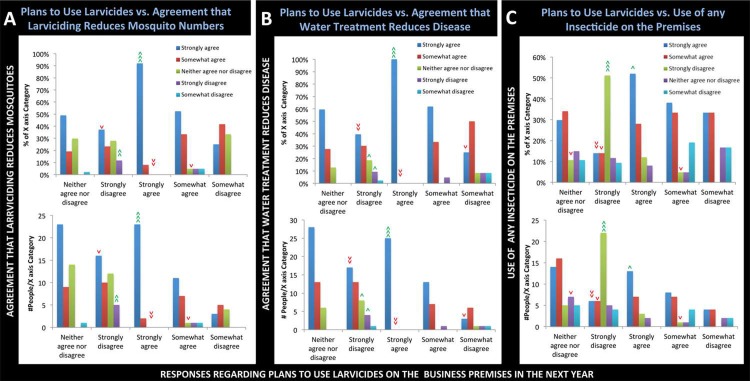
Assessment of respondents’ willingness to use larvicides on the premises.Likert-scale responses to the question of whether the business plans to use larvicides on the premises in the next year (X-axes) vs. A) Agreement that larvicide use will reduce the number of mosquitoes, B) Agreement that treatment of water where mosquitoes breed will reduce disease, and C) Respondents’ willingness to use any insecticide on the premises (Y-axes). The percentages (upper graph in each panel) and numbers (lower graphs) of the X-axis category respondents providing the answers indicated are shown. >>> = very highly significant, >> = very significant, > = significant, with green signifying a higher than expected percentage/number for a given X-axis category and red denoting a lower than expected percentage/number of respondents for a given X-axis category. See text for additional details regarding statistical analyses and discussion of significant results.